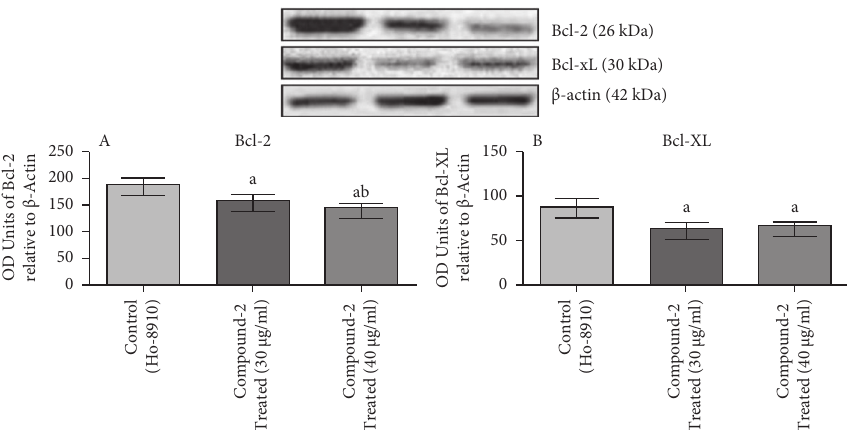
Figure 11: Effect of compound 2 on antiapoptotic protein (Bcl-2 and Bcl-xL) expression in HO-8910 cells. Cells were treated with 30 and 40 μ g of compound for 24h. The protein levels were quantified using the densitometry analysis and are expressed in relative intensity arbitrary unit. Each bar represents mean ± SEM of six independent observations. (a) Compared to control; (b) compared to 30 μ g of compound